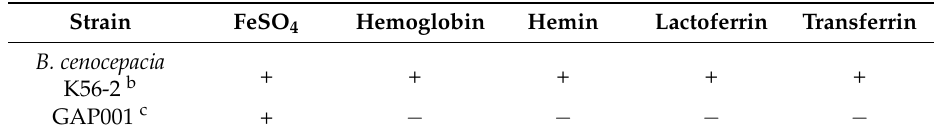
Table 3. Iron utilization assay a .